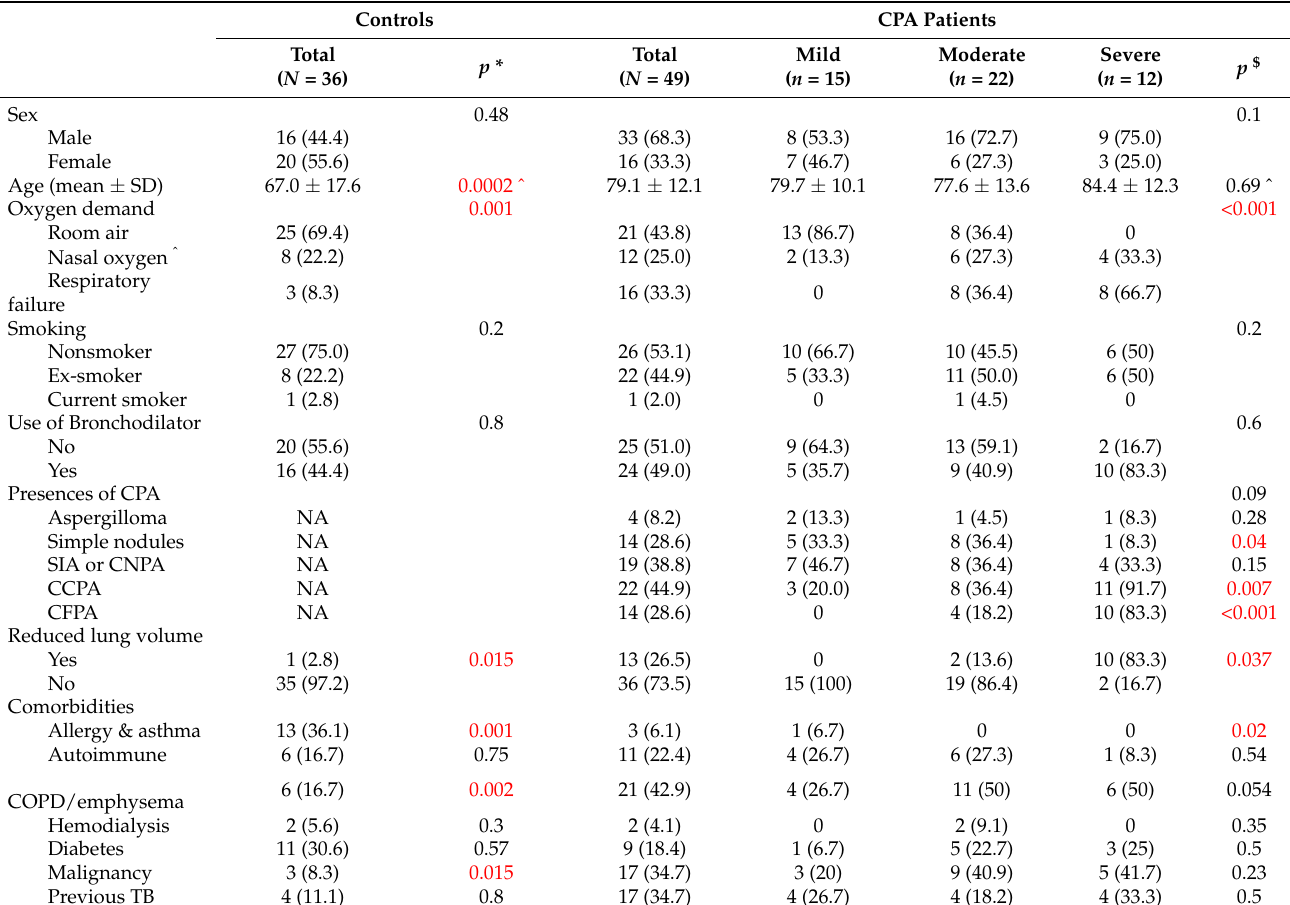
Table 1. Clinical characteristics of the study